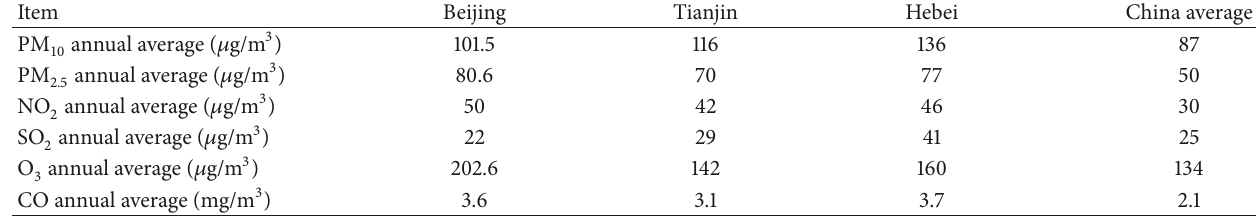
Table 3: Environmental status of the BTH region in 2015.